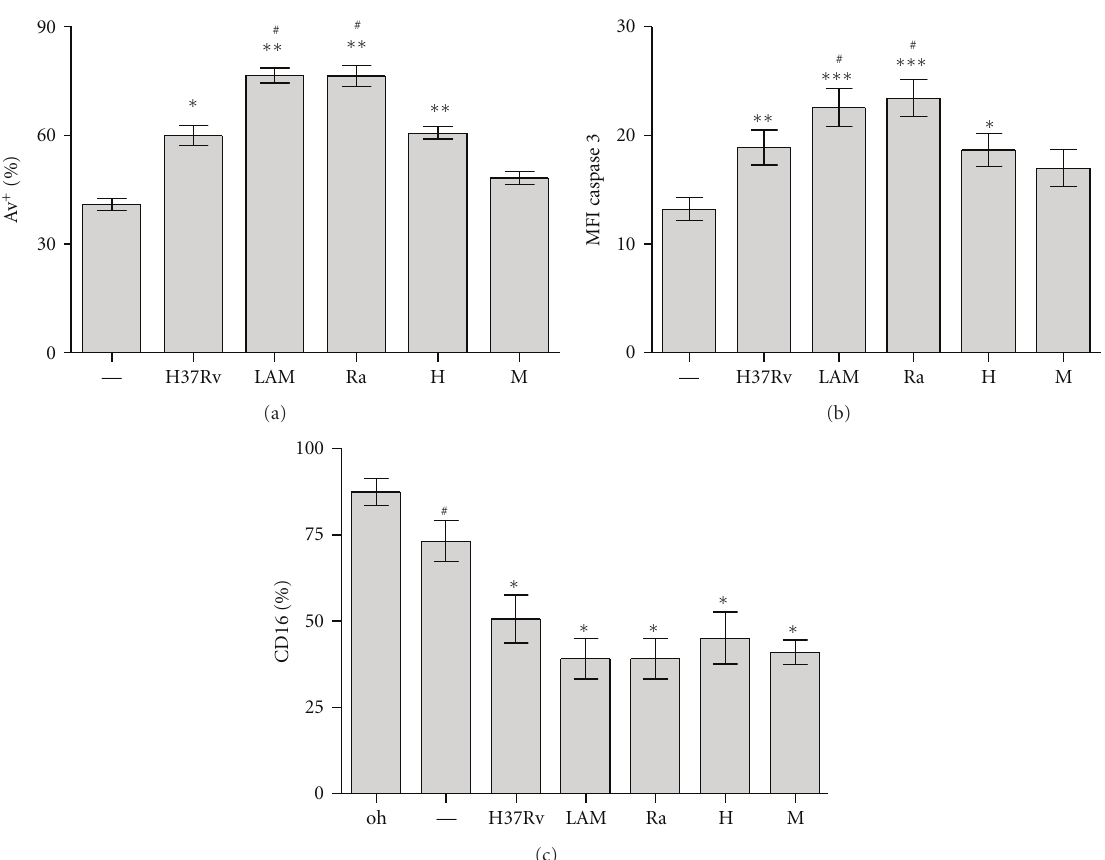
Figure 2: PMN apoptosis induced by di ff erent Mtb strains. PMNs (3 × 10 6 /mL) were cultured in media alone (control, —) or stimulated with Mtb strains (H37Rv, LAM, Ra, H, and M) at 1:2 Mtb :PMN ratio and parameters of apoptosis were evaluated by flow cytometric analysis. (a) Expression of Annexin V-FITC (AV-FITC) on PMN cultured for 18 h. Results are expressed as media ± SEM of percentage of positive cells ( n = 20). Control (—) versus LAM, Ra, and H: ∗∗ P < 0 . 001; H37Rv: ∗ P < 0 . 01; LAM and Ra versus other strains: # P < 0 . 001. (b) Intracellular expression of activated cytoplasmic protein caspase-3 in PMN after 5h culture with or without Mtb stimulation. Results are expressed as media ± SEM of MFI. Control (—) versus LAM and Ra: ∗∗∗ P < 0 . 001; H37Rv: ∗∗ P < 0 . 01; H ∗ P < 0 . 05; LAM and Ra versus other strains: # P < 0 . 001. (c) The percentage of fresh (0h) and 16 h cultured cells expressing FcRIIIb (CD16) was measured. 0h versus control: # P < 0 . 0002; control vesrus Mtb strains: ∗ P < 0 .